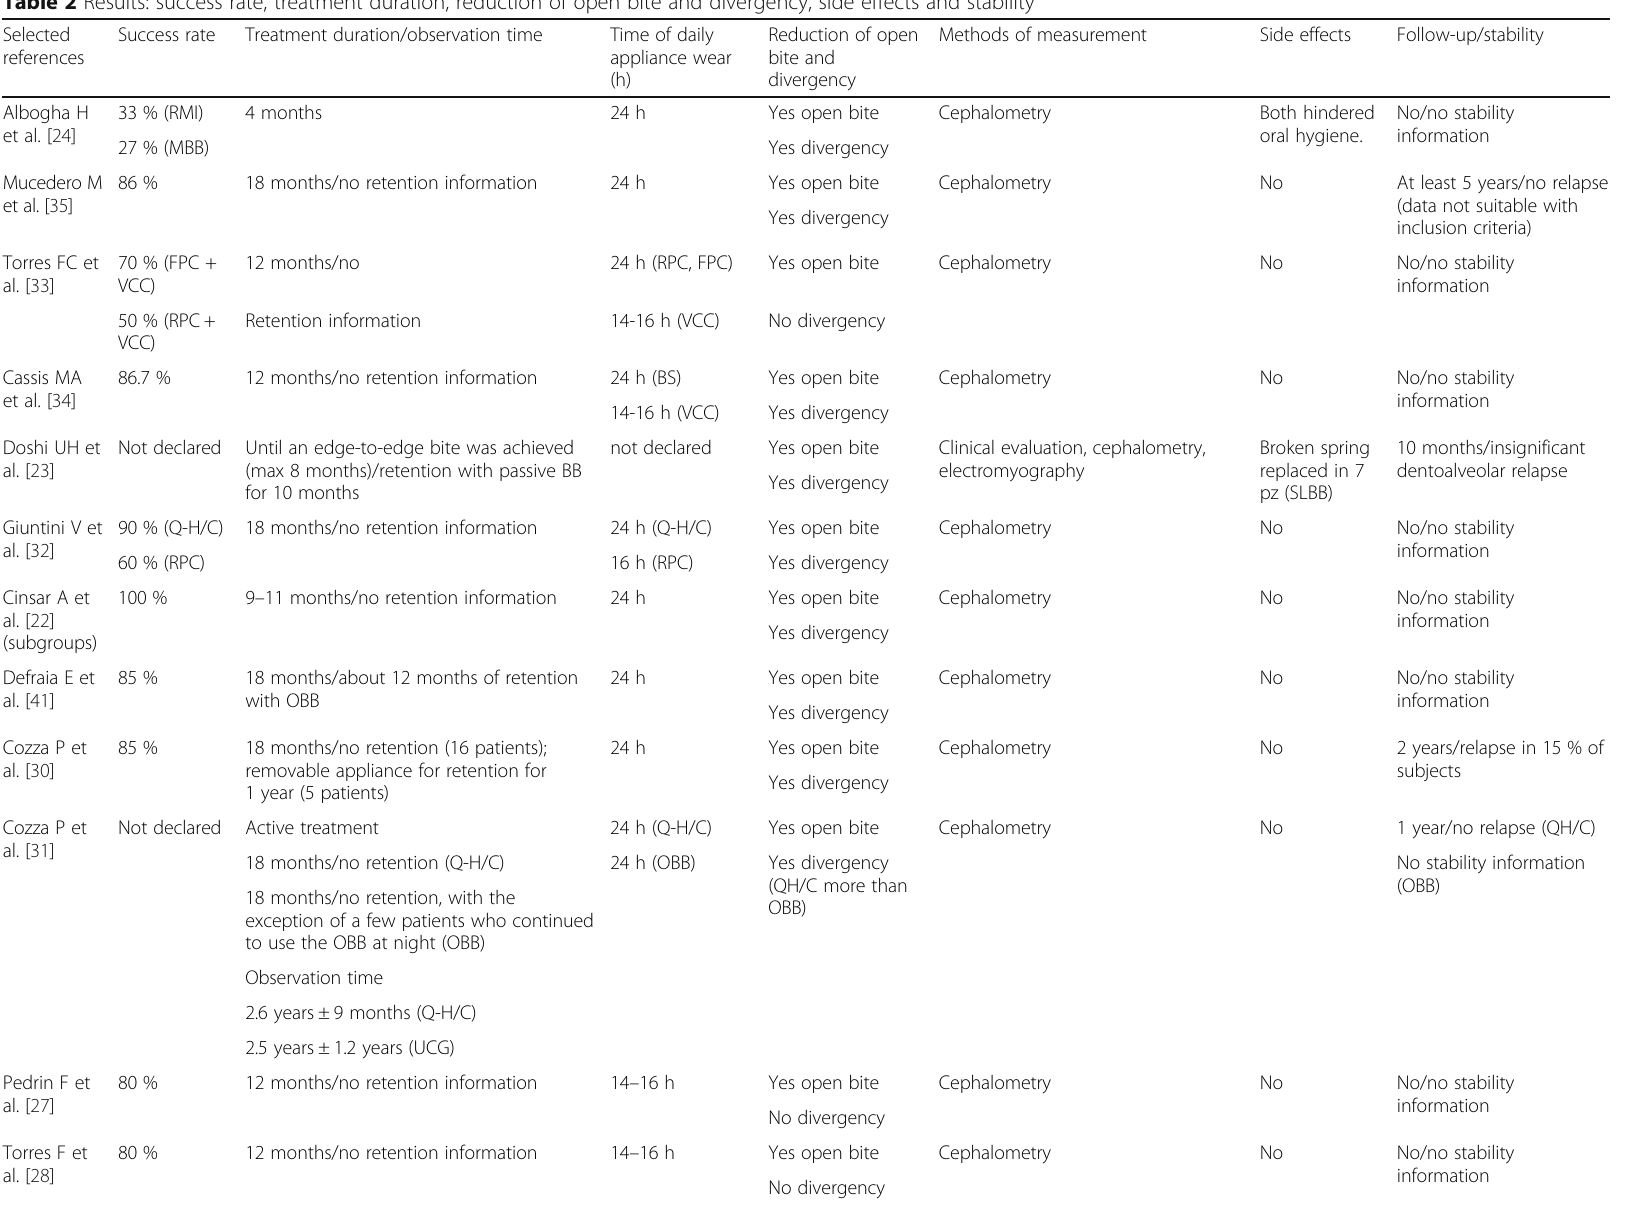
Table 2 Results: success rate, treatment duration, reduction of open bite and divergency, side effects and stability Selected